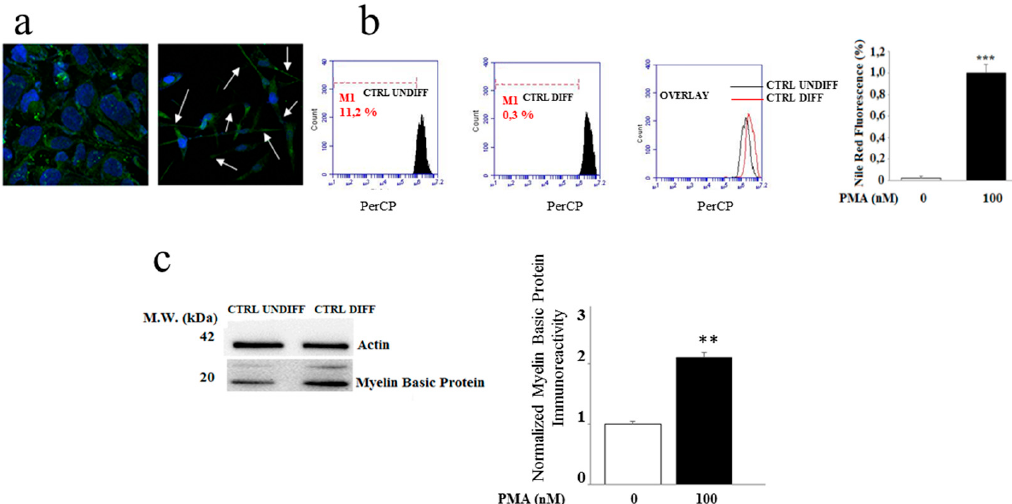
Figure 2. Differentiation of the MO3.13 cell line ( a ) Morphological structure of oligodendrocytes through confocal microscopy. The MO3.13 cell line was differentiated by means of treatment with Phorbol 12-myristate 13-acetate 100 nM for five days. At the end of the treatment, the cells were exposed to the β -actin primary antibody in order to assess the cell morphology. On the left of panel ( a ), there are undifferentiated oligodendrocytes; on the right of panel ( a ) there are differentiated oligodendrocytes. The white arrows indicate the extensions formed following the differentiation of MO3.13. ( b ) The lipid quantification, both in differentiated and in non-differentiated oligodendrocytes, through flow cytometric analysis. The oligodendrocytes were incubed with Nile Red. The overlapping of fluorescence peaks, obtained through the analysis of undifferentiated and differentiated cells, is shown in the overlay panel. On the right of panel ( b ), the quantification of the flow cytometric reading is shown. ( c ) Expression of the Myelin Basic Protein (MBP) through western blotting. On the right of panel ( c ), the quantification of the bands thus obtained is indicated. Values of three independent experiments are expressed as mean ± standard deviation (sd). ** denotes p < 0.01 vs control; *** denotes p < 0.001 vs control; Analysis of Variance (ANOVA) followed by the Tukey- Kramer comparisons test).